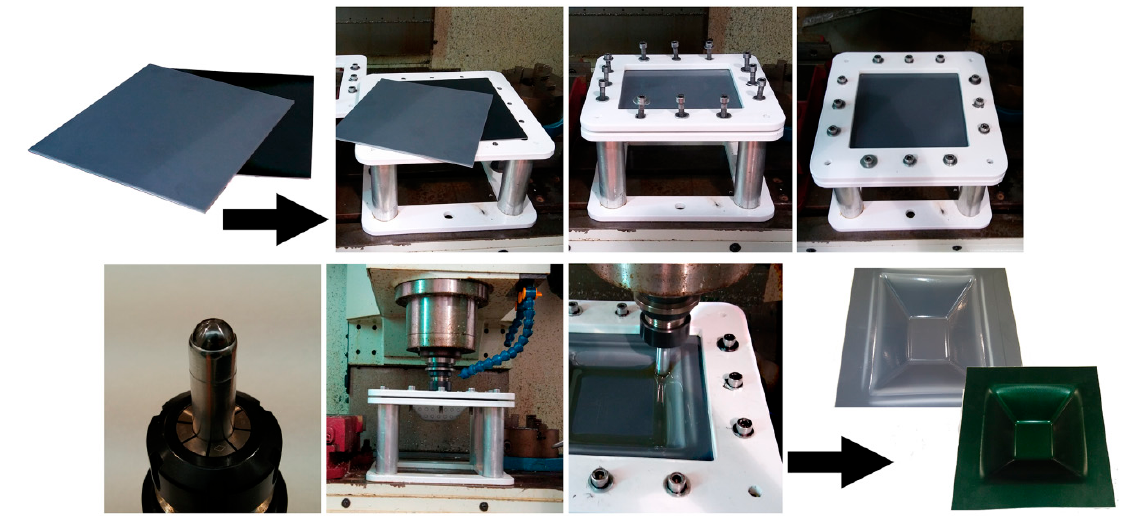
Figure 3. Experiment set-up and manufactured pieces.